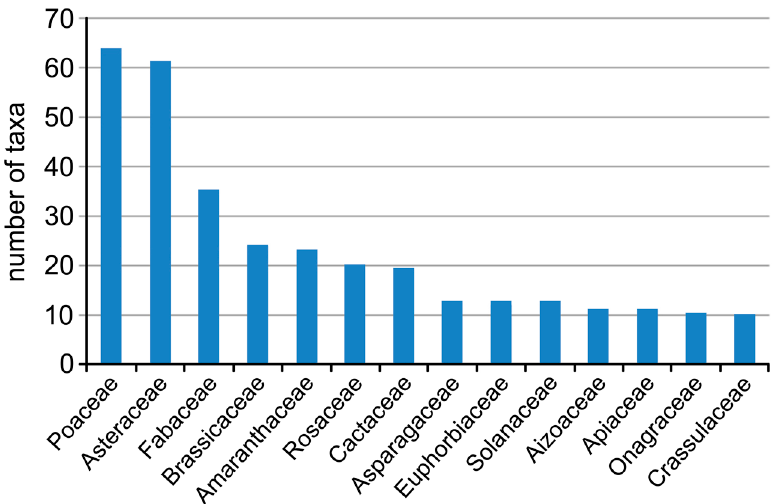
Figure 4. Families with the highest diversity of alien established taxa in the Catalan